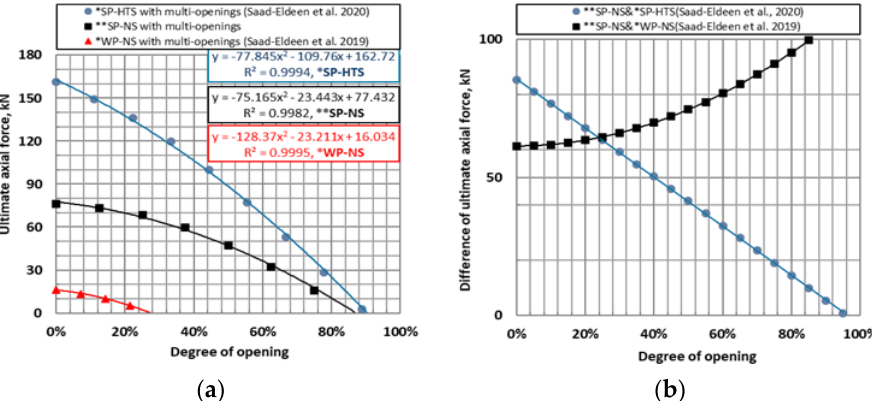
Figure 21. Ultimate axial force as a function of DoO ( a ) and trend of the capacity difference for SP-NS, * WP-NS of [15] and * SP-HTS of [18], w o ∈ [0,3] mm ( b